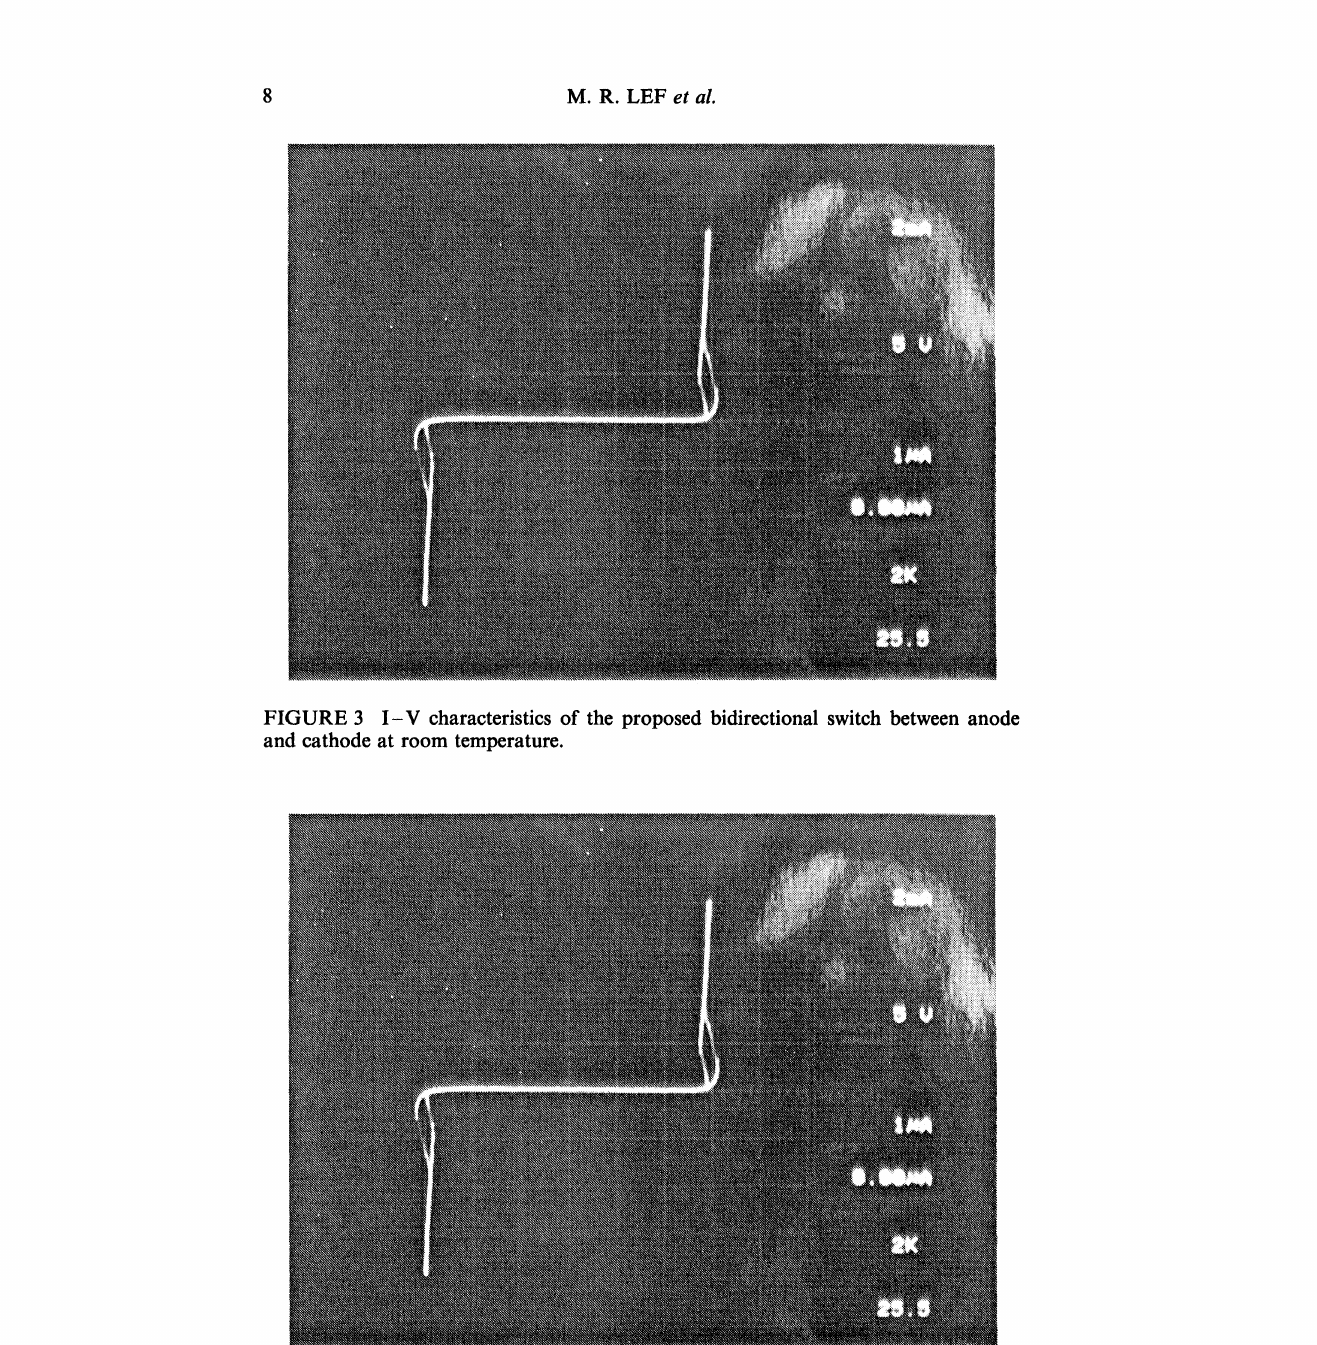
FIGURE 4 Room temperature I-V characteristics of common-emitter configuration under a base current injection with respect to the